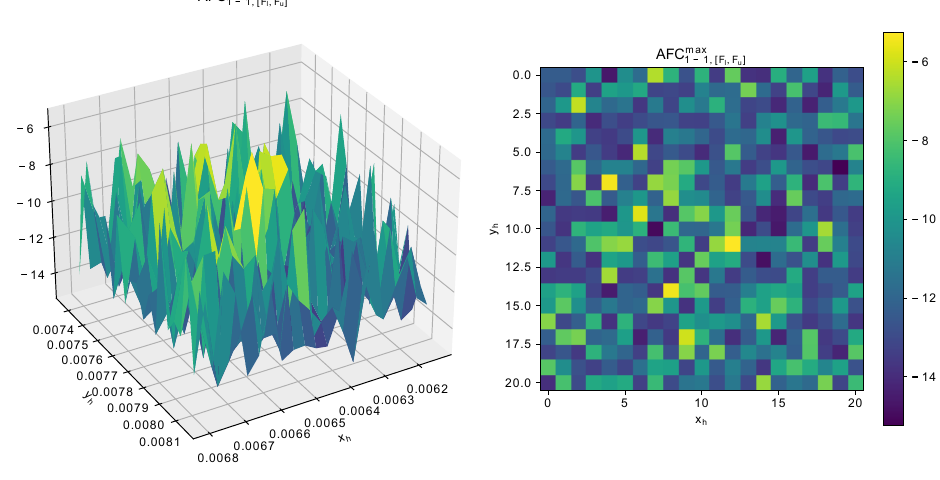
Figure 14. Dependence of AFC max around scaled solution for 5-mode resonator. 1 − 1, [ F l , F u ] The landscape of measured AFC max with different x h or y h around the scaled 1 − 1, [ F l , F u ] solution shows that this constraint, i.e., it should be less then − 14, could be difficult to satisfy, as some of the points may get up to −